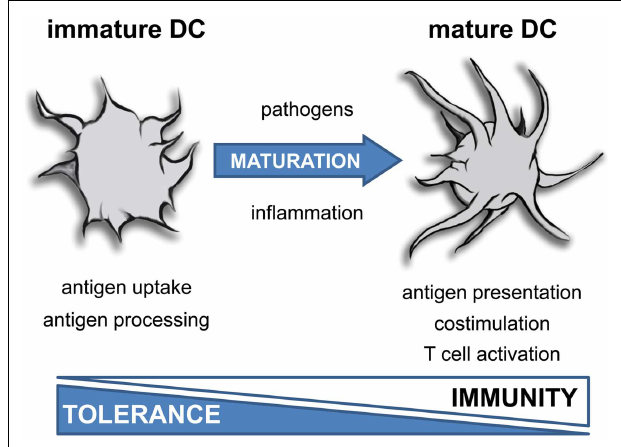
FIGURE 1 | Function of dendritic cells depends on maturation. Inflammatory mediators induce terminal differentiation of immature DC into fully matured immunogenic DC.This process is associated with a dramatic change in morphology, a reduced uptake of antigens and impaired antigen processing activity. Furthermore, mature DC exhibit a strong costimulatory andT cell activating